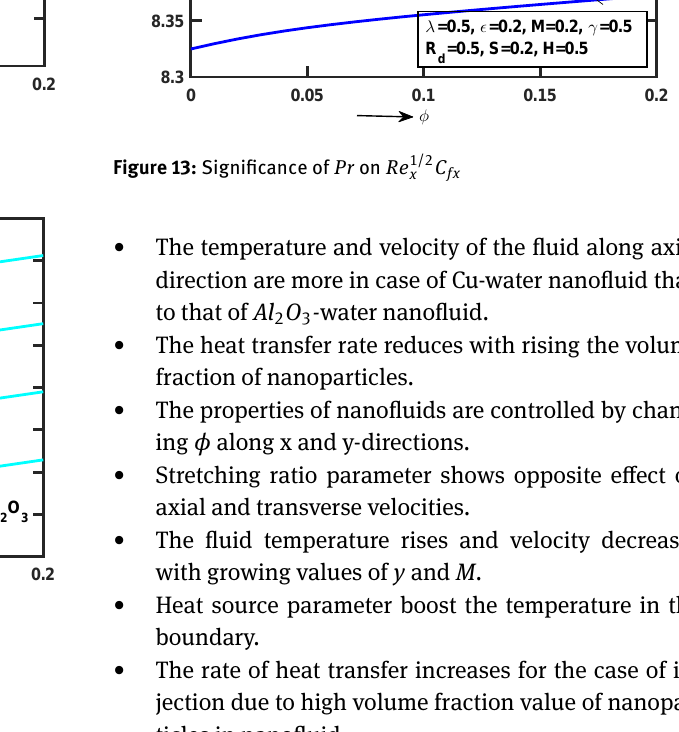
Figure 11: Significance of S on Re